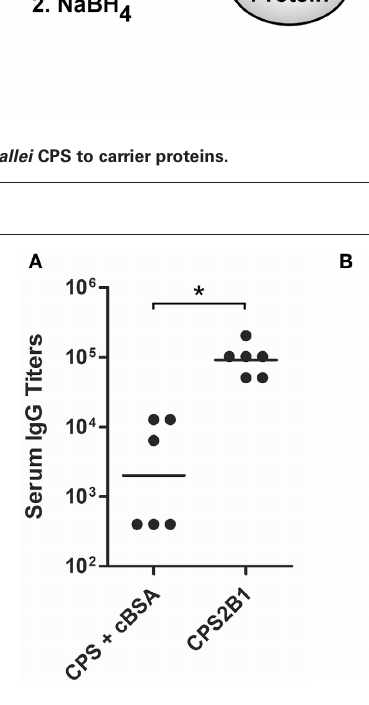
FIGURE 5 | Characterization of murine immune responses against the CPS2B1 conjugate. (A) ELISA was used to determine the total serum IgG response of mice immunized with CPS2B1 or the unconjugated controls. Individual symbols represent a single mouse while black bars indicate geometric means. ∗ , P < 0 . 05. (B) Western immunoblotting was used to assess the reactivity of pooled anti-CPS2B1 immune serum ( n = 6) with B. pseudomallei 1026b (Bp) and B. mallei ATCC 23344 (Bm) whole cell lysates. The positions of protein molecular size standards are indicated on the